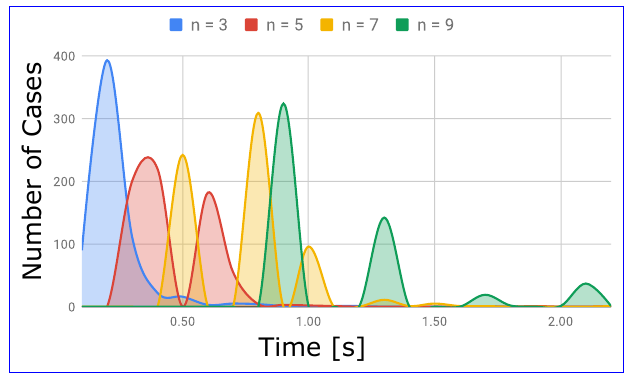
Figure 9. Convergence time of the cases classified in group